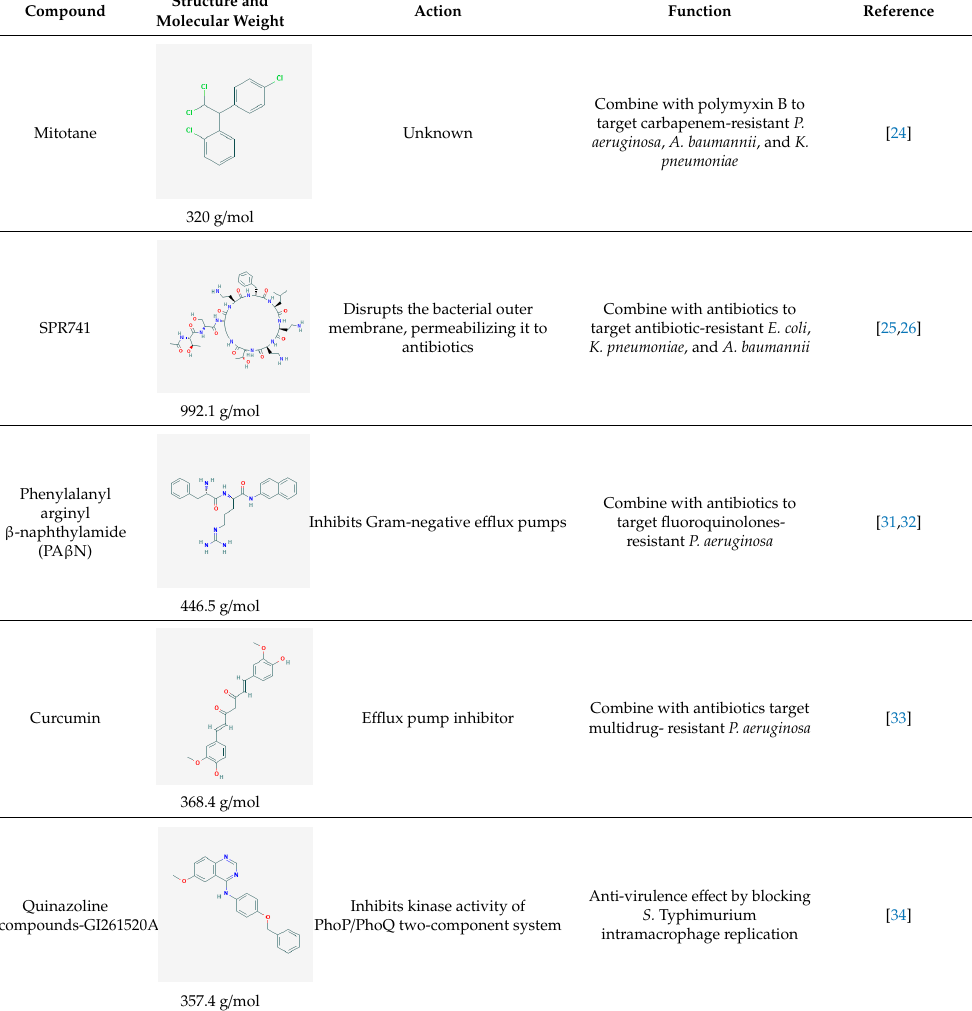
Table 1. Molecular characteristics, action, and function of compounds against bacterial infections.